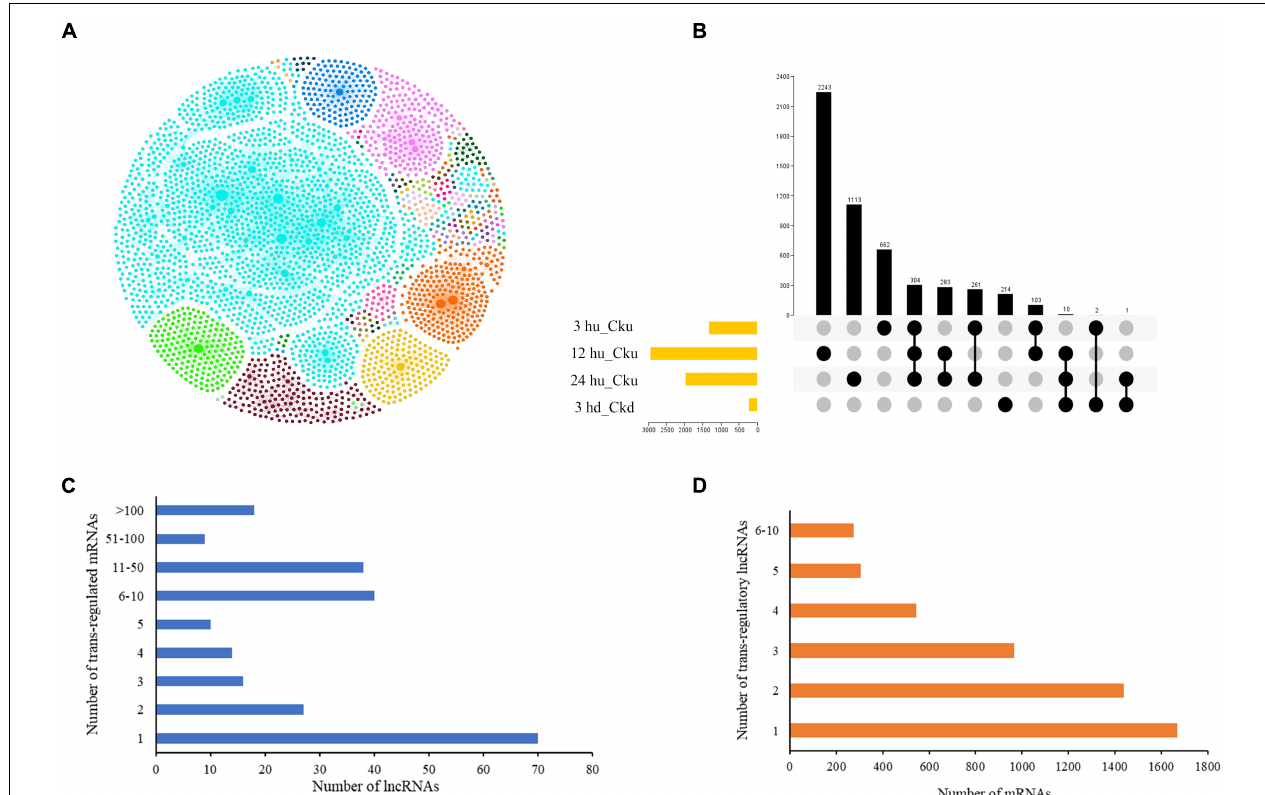
FIGURE 2 | Interactions between lncRNAs and their trans -regulated mRNAs in tobacco plants. (A) The lncRNA-mRNA interaction network, including comparisons between all treatment groups (3 hu, 12 hu, 24 hu, and 3 hd vs. the respective control group). The nodes represent lncRNAs and mRNAs, and the edges represent the interactions between them. The node size corresponds to the number of interacting mRNAs or lncRNAs, and the edge color denotes the number of comparisons where different lncRNA-mRNA connections are present. (B) A Venn diagram displaying the common and specific matched lncRNA-mRNA pairs. (C) Number of differentially expressed mRNAs regulated by differentially expressed lncRNAs. (D) Number of differentially expressed lncRNAs regulating differentially expressed